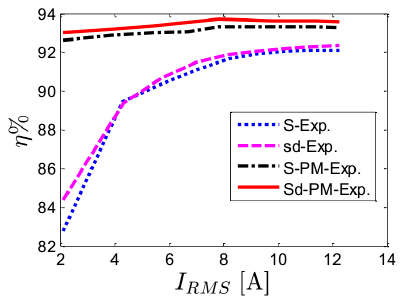
Figure 26. The measured efficiency of the four prototypes at optimal current angles and rated speed (3000 rpm).